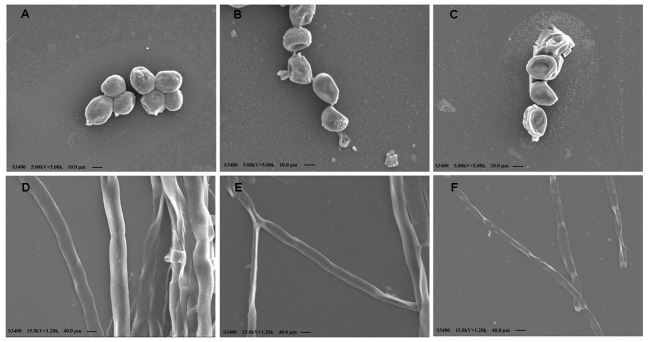
Scanning electron microphotographs of P. expansum F-WY-12-02. (A) Untreated spores. (B) Cells treated with Cin/Cit at 1/2 MIC. (C) Cells treated with Cin/Cit at 2MIC. (D) Untreated mycelia. (E) Mycelia treated with Cin/Cit at 1/2 MIC. (F) Mycelia treated with Cin/Cit at 2 MIC.